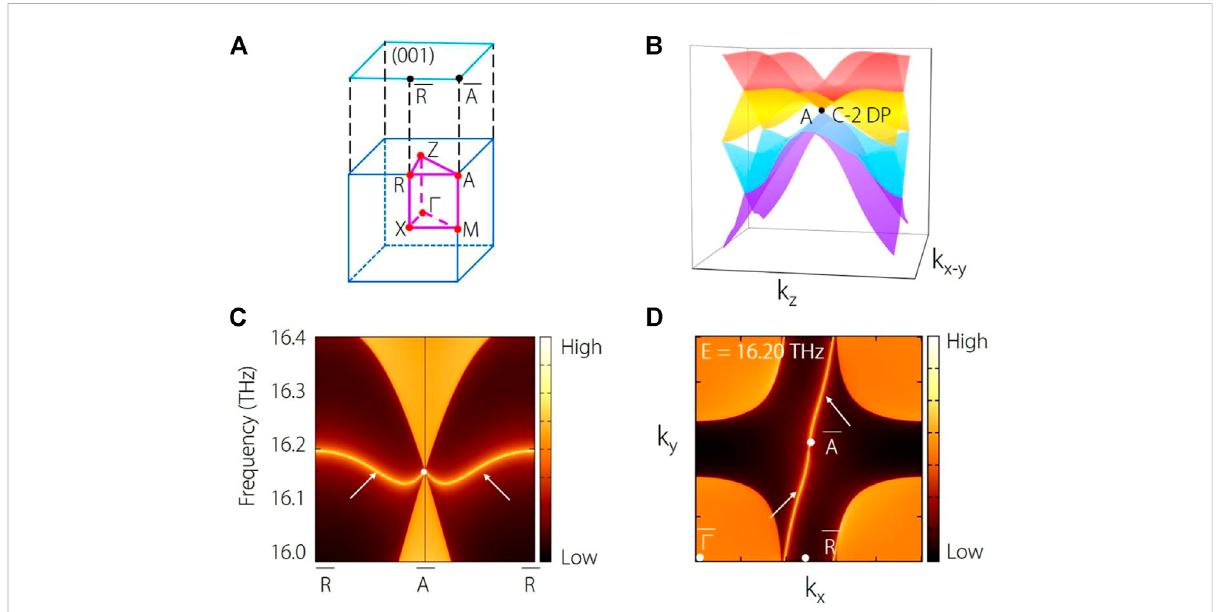
FIGURE 3 The bulk BZ and the corresponding (001) surface BZ. (B) Three-dimensional plot of the phonon bands around the charge-two Dirac point (C- 2 DP) at (A) . (C) Projected spectrum on the (001) surface, and (D) the corresponding constant frequency slice at 16.20 THz.